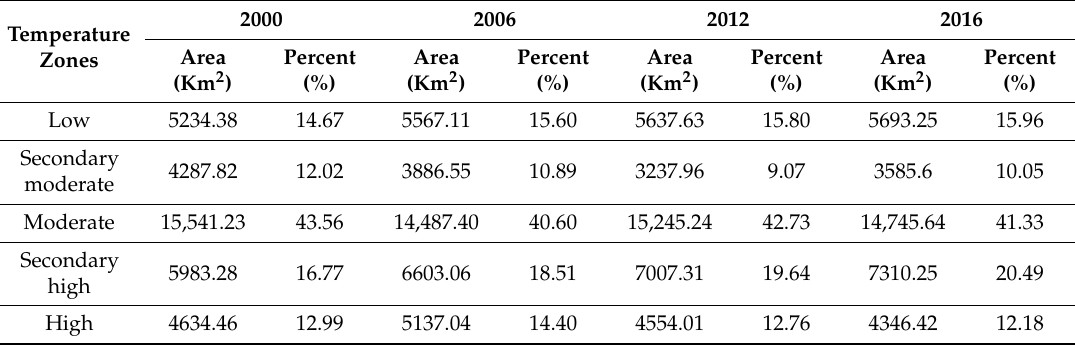
Figure 3. The spatial ( a ) and temporal annual mean ( b ) temperature changes during 2000 to 2016. Table 4. Statistics of the pixel in the five temperature zones for the years 2000, 2006, 2012 and